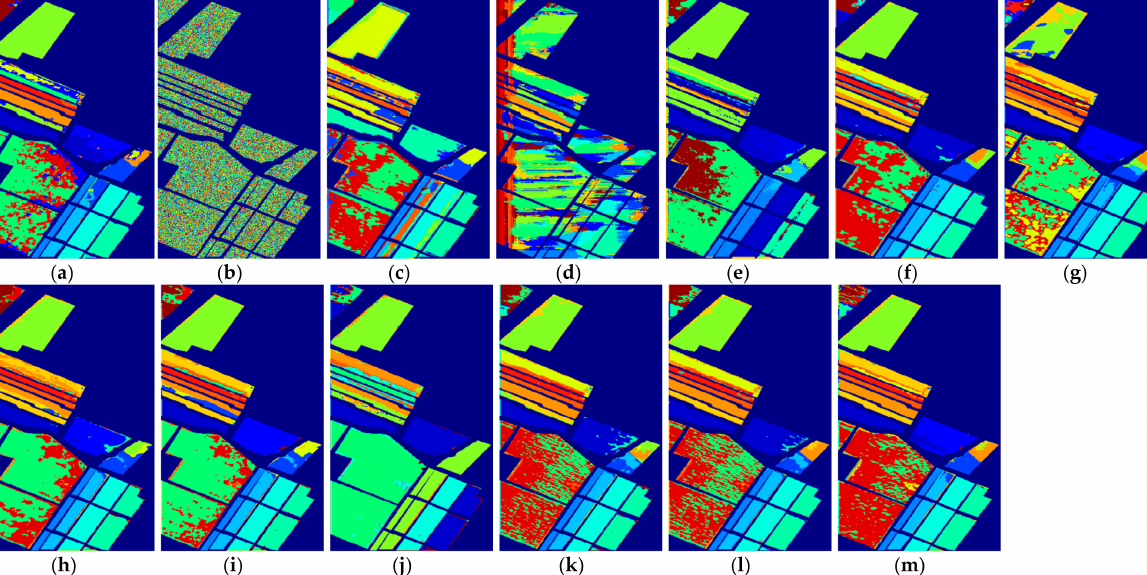
Figure 14. The classification maps of all methods with one sample on Salinas dataset. ( a ) SVM; ( b ) SS-LapSVM; ( c ) 3D- DENSEnet; ( d ) 3D-Gan; ( e ) SS-CNN; ( f ) 3D-CNN; ( g ) 3D-CNN k - means -means method, soft label with the proposed method. The experiments were conducted with five training samples per class on the Indian Pines and PaviaU